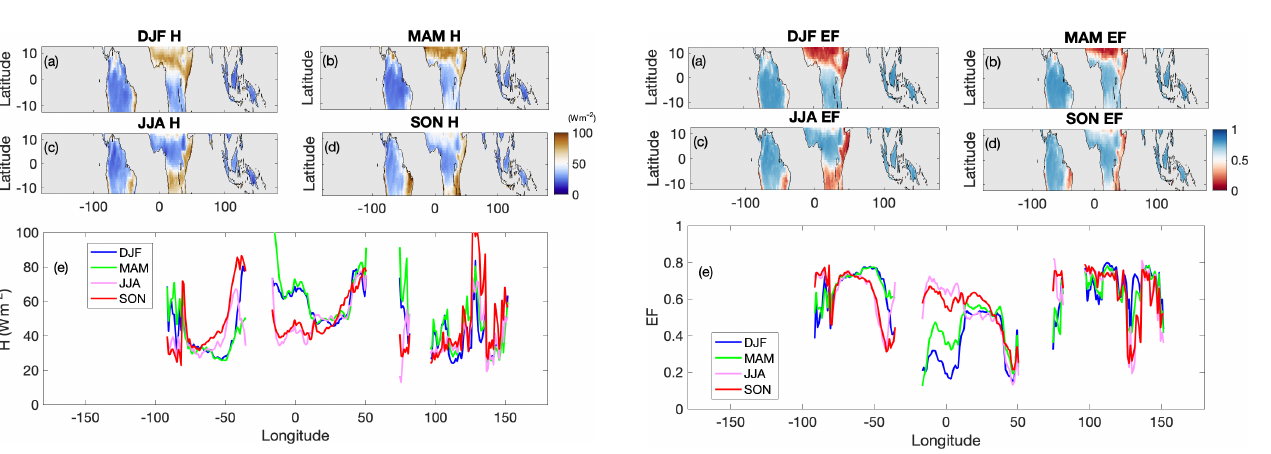
Figure 7. Same as Fig. 4 but for sensible heat flux H. Figure 8. Same as Fig. 4 but for evaporative fraction (EF), the ratio of LE to H +